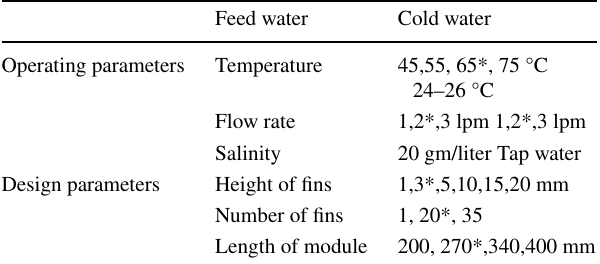
Table 3 Experimental values of design and operational parameters